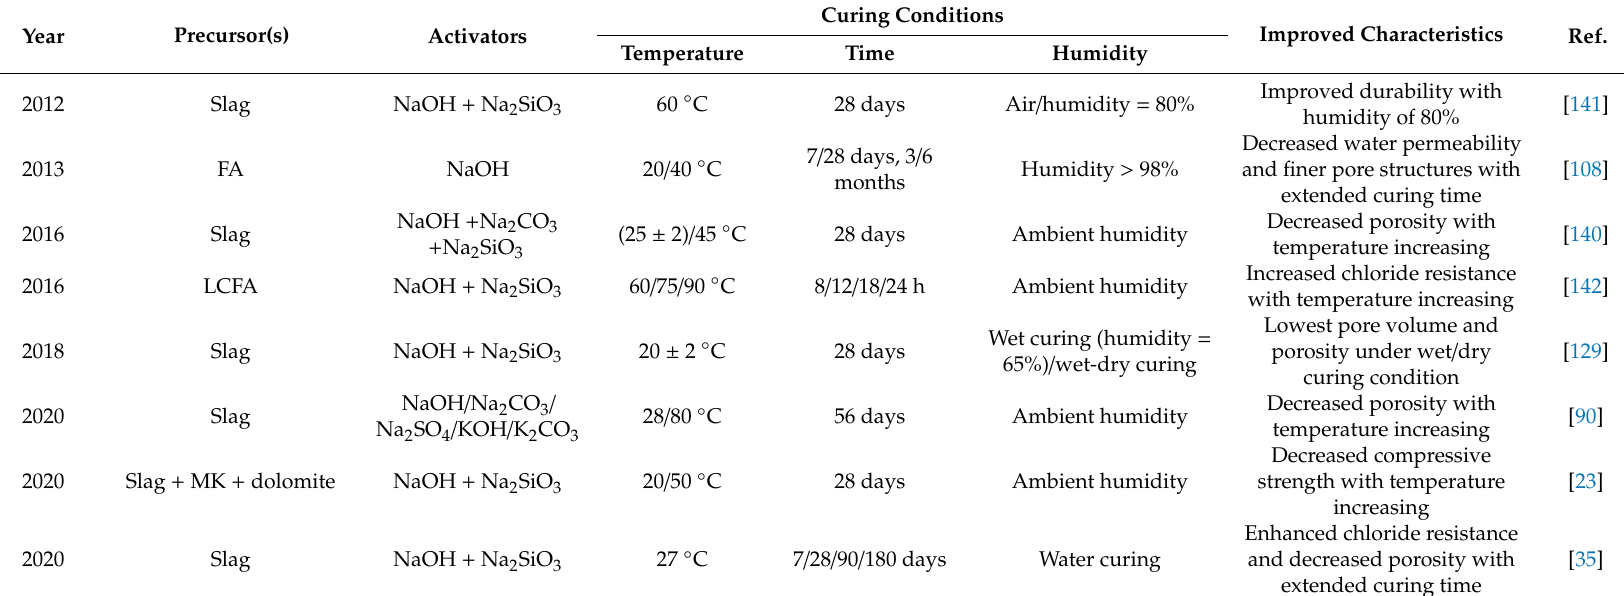
Table 5. Curing conditions a ff ecting the chloride resistance of